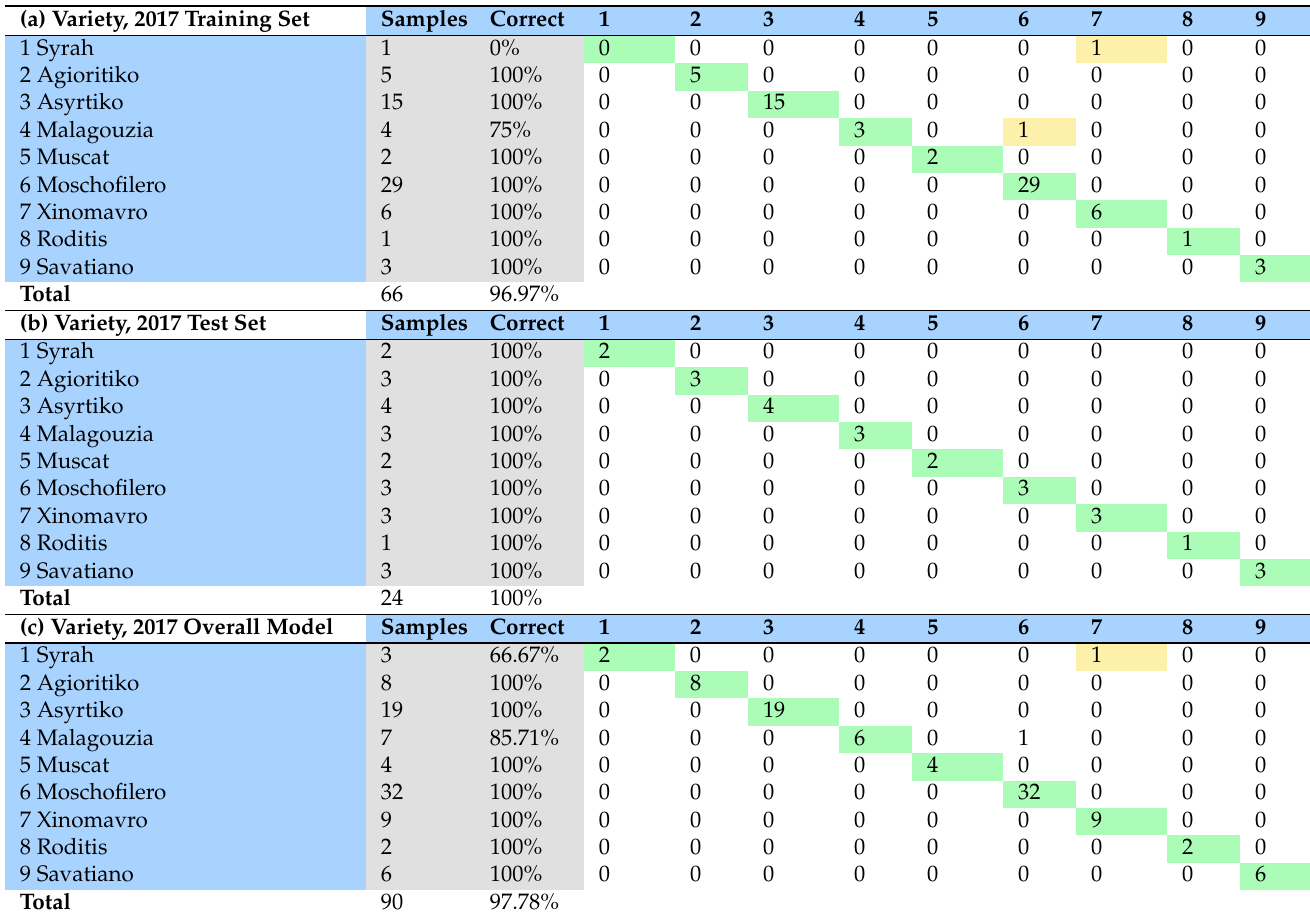
Table 5. Misclassification tables produced for the OPLS-DA models of the wine samples of 2017 classified regarding variety, where ( a ) training set, ( b ) test set, ( c ) overall